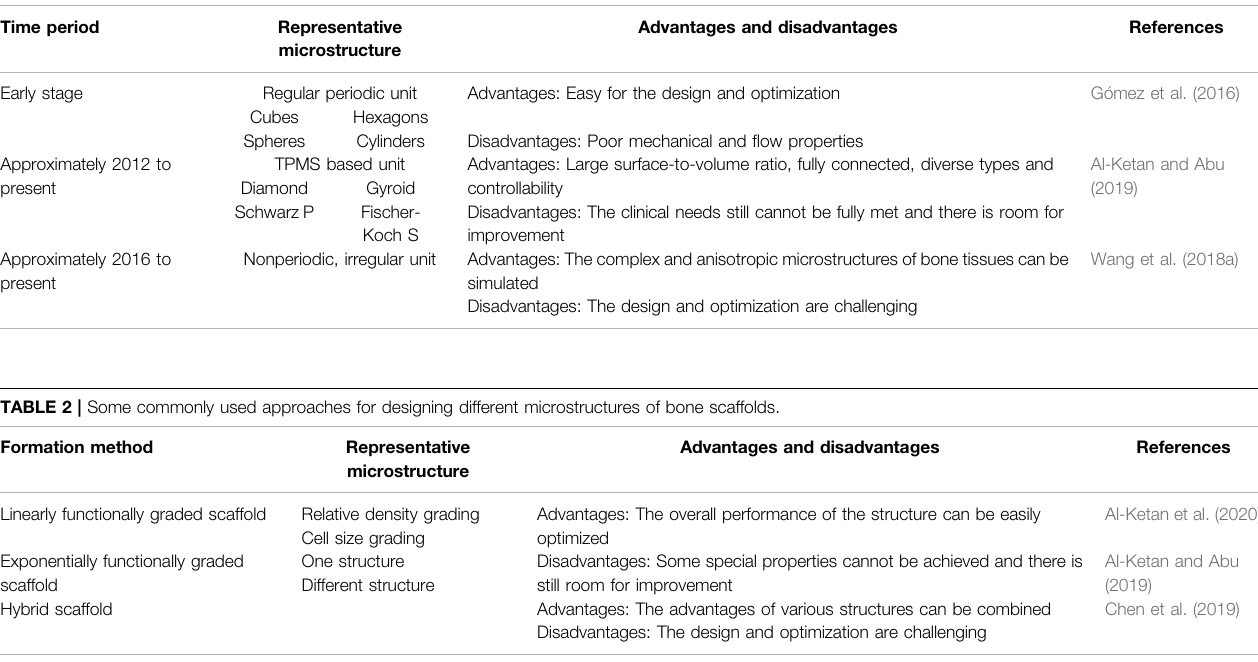
TABLE 1 | Three main classes of the microstructure of the bone